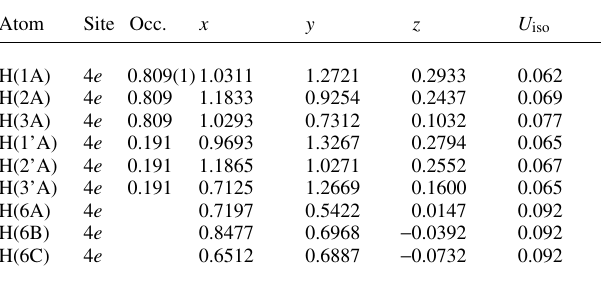
Table 2. Atomic coordinates and displacement parameters (in Å 2 ) .